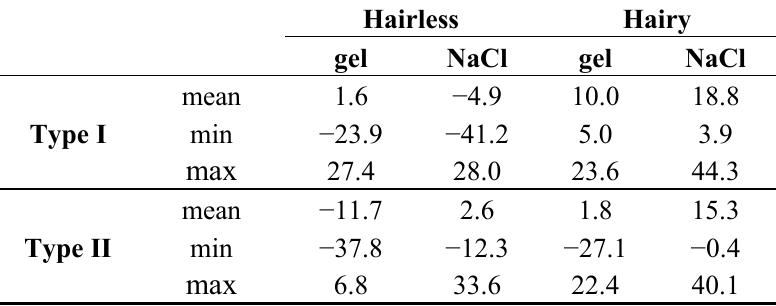
Table 1. Textile electrode 50 Hz sensitivity (dB, mean and standard deviation; std). The two electrode types were compared to standard electrodes, using contact gel or NaCl respectively. A negative sign means that the textile electrode was less sensitive to this